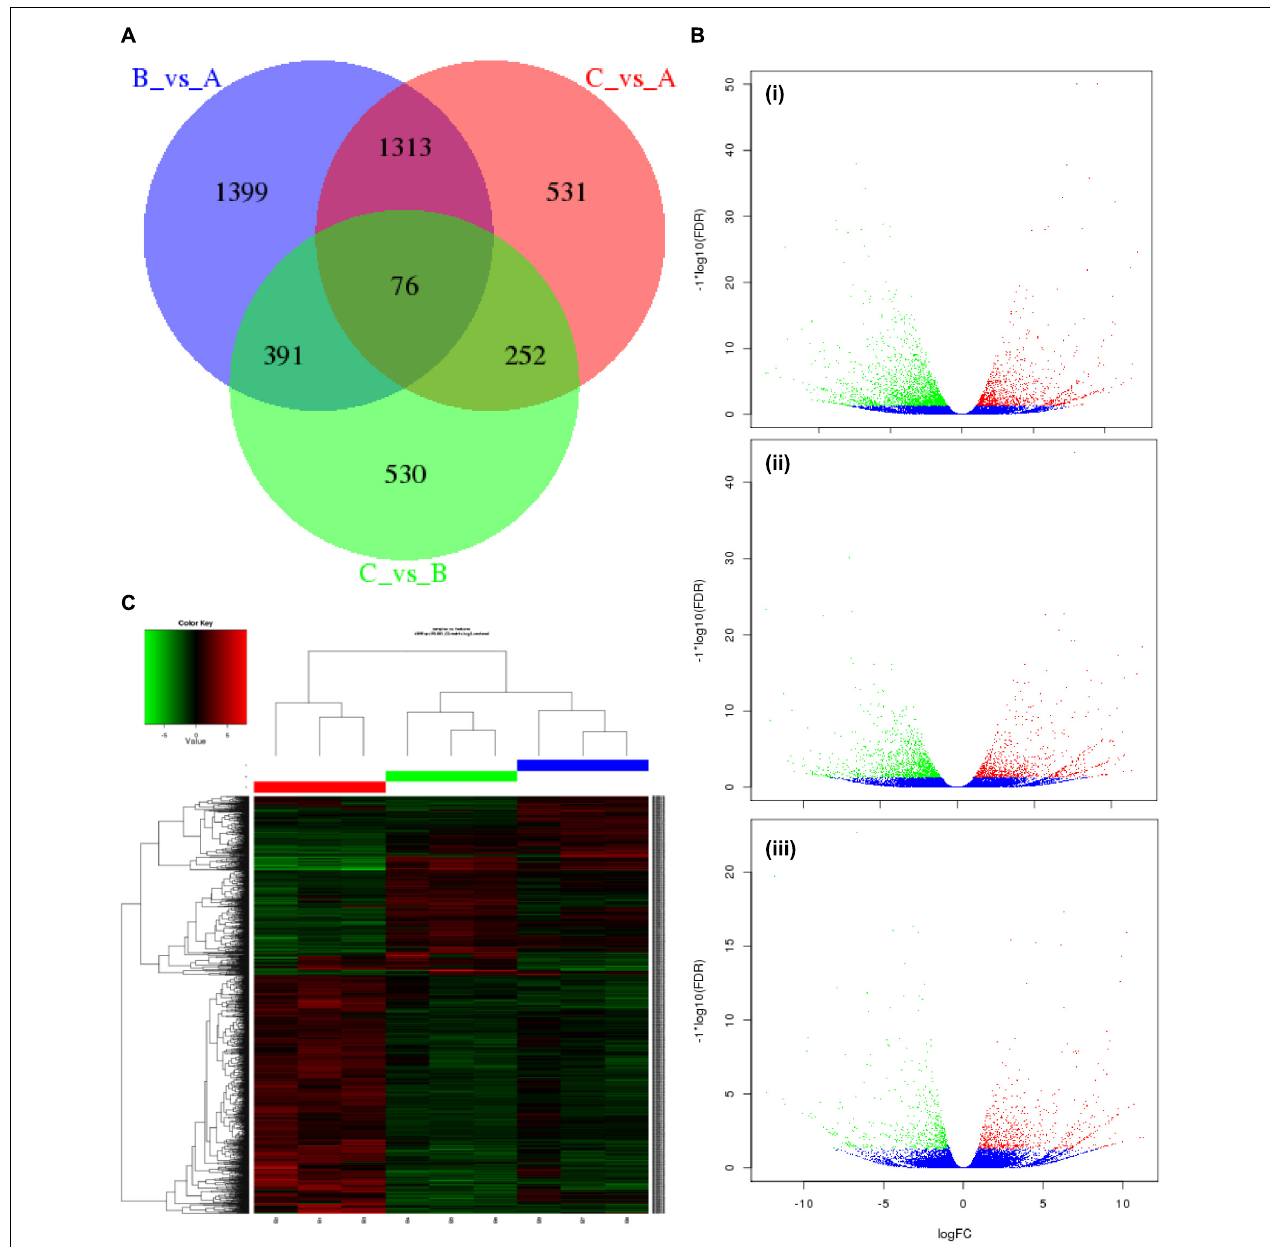
FIGURE 3 | Characteristics of differentially expressed genes (DEGs) in P. antidotale . (A) Venn diagram showing specific and common salt responsive DEGs among the RNA-seq datasets used in this study: A = control, B = low salinity, C = high salinity. (B) Volcano maps representing expression pattern of DEGs (FDR ≤ 0.05 and | log2Ratio| > 1) recorded in treatments: (i) low salinity/control, (ii) high salinity/control, and (iii) high salinity/low salinity. In this study, red spots represent upregulated DEGs, while green spots indicate downregulated DEGs. Those shown in blue are unigenes that did not show obvious changes in salt-stressed plants. (C) Heat map representation of DEGs (B1–B3: 0 mM NaCl; B4–B6: 100 mM NaCl, B7–B9: 300 mM NaCl).